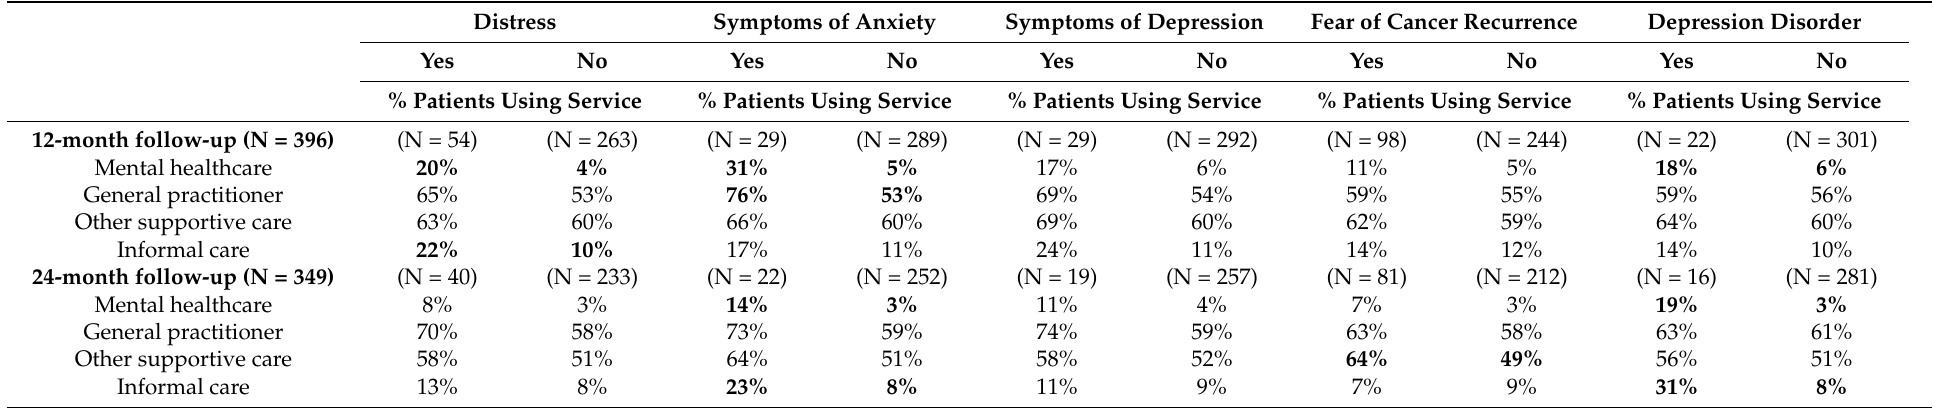
Table A2. Psychological problems at 12-month follow-up in relation to healthcare use at baseline, 12-, and 24-month follow-up.